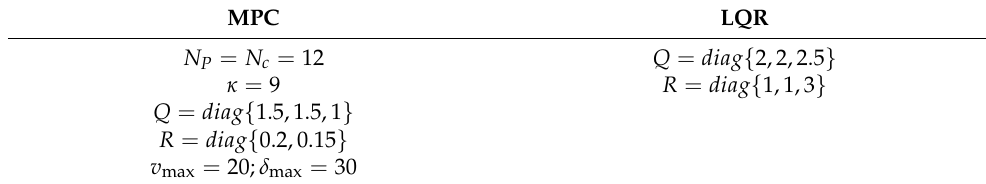
Table 2. MPC and